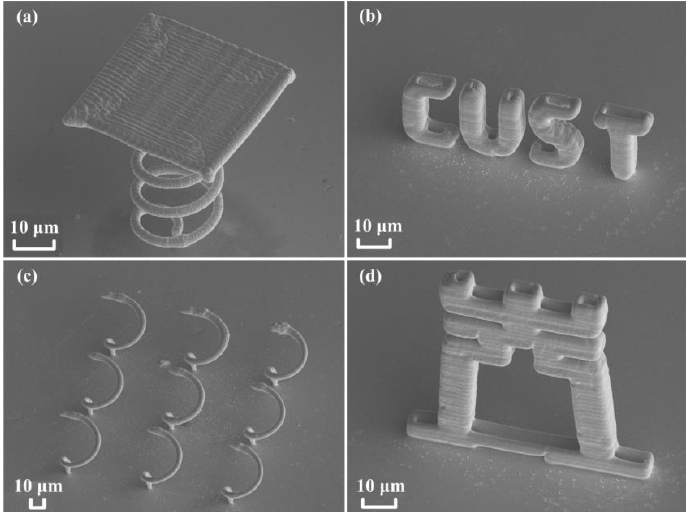
Figure 5. The complex microstructures precisely manufactured by electrochemical micro-additive manufacturing technology. ( a ) The structure with a flat on the top of lower spiral. ( b ) The abbreviation of the English alphabet for Changchun University of Science and Technology. ( c ) The 3 × 3 array structures of a half-circle spiral. ( d ) A Chinese character "light" shape.